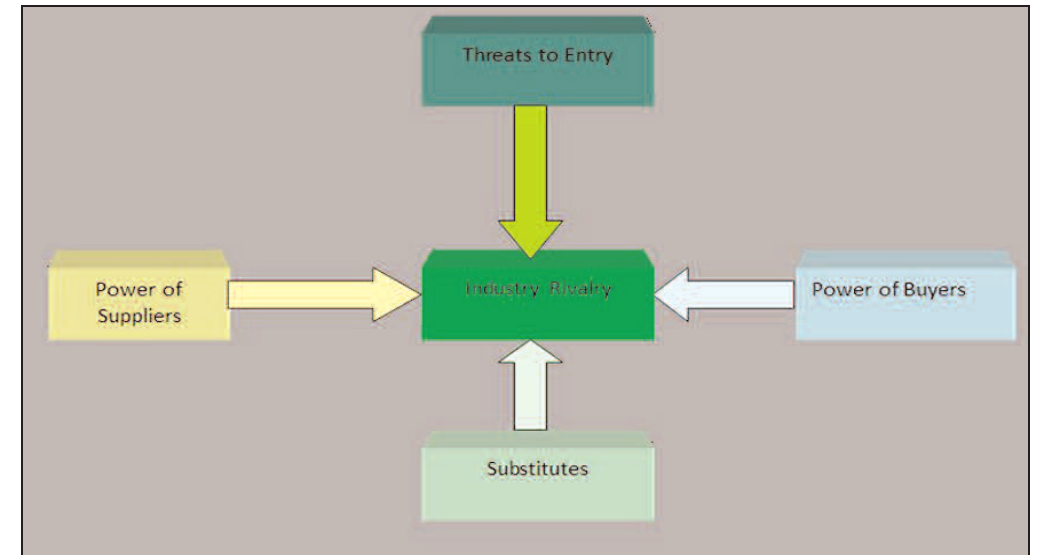
Figure 1. Trajectories of